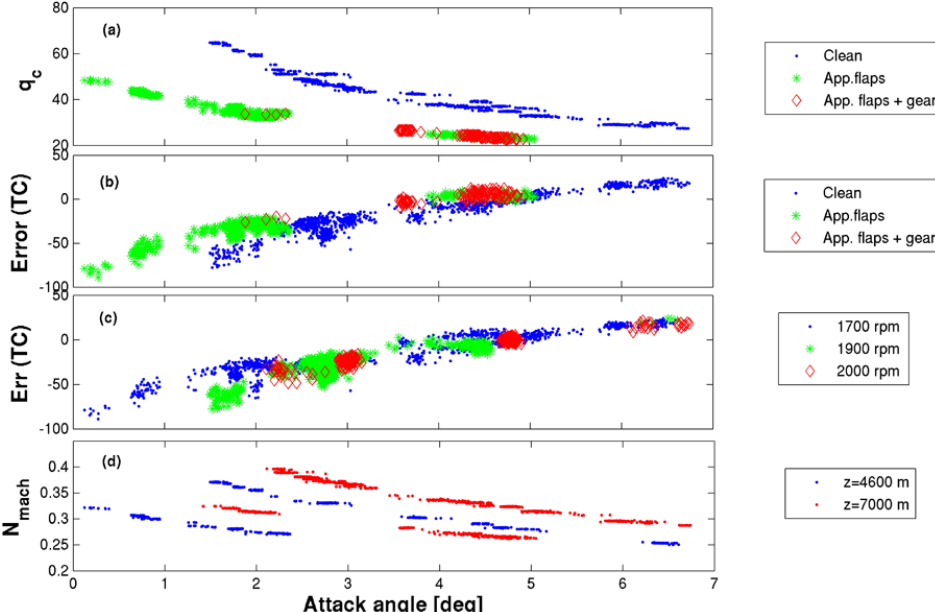
Fig. 2. Scatter plots (10Hz data) as functions of attack angle [deg] for various flight configurations and altitudes as indicated in legends: (a) dynamic pressure q c [hPa], (b) and (c) static pressure error [Pa] determined by TC, and (d) Mach number.